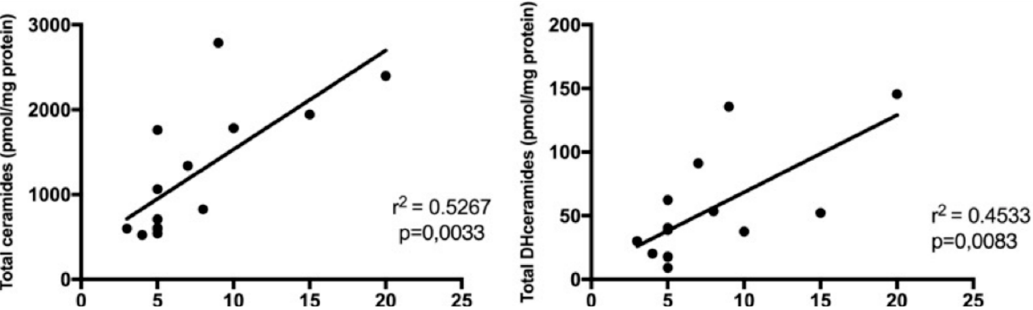
Figure 6. Linear regression graphs showing the correlation between the rate of MIB ‐ 1 staining and total ceramides .